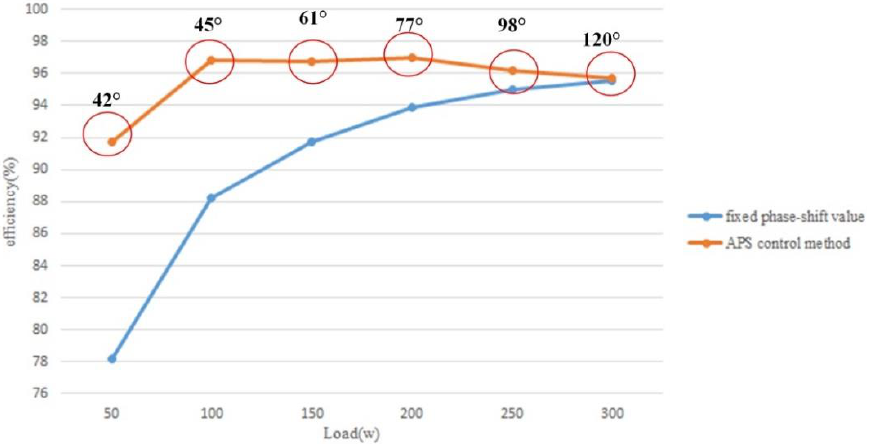
Figure 24. Measured efficiency curves of different control methods under boost-discharging mode.